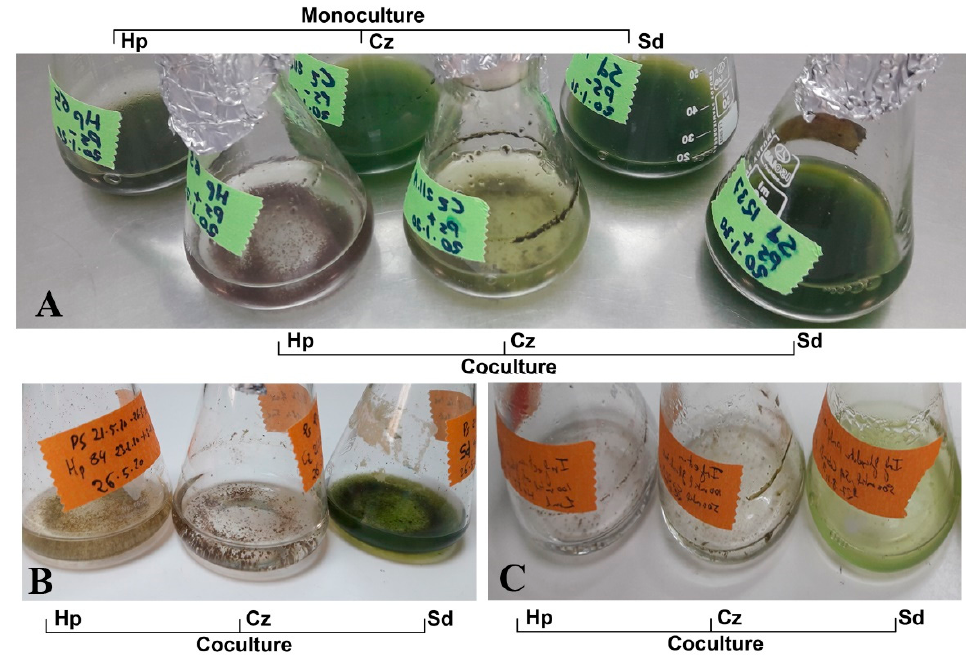
Figure 2. Virulence of different types of P. sedebokerense inoculum against H. pluvialis (Hp), C. zofingiensis (Cz) and S. dimorphus (Sd) algal cultures. ( A ) Algal monocultures inoculated with logarithmic P. sedebokerense cultures, 5 days after inoculation and negative controls (the same algal monocultures without inoculation of the parasite). ( B ) Algal monocultures 2 weeks after inoculation with Ps-Hp coculture (same volume of inoculum to each algal culture). ( C ) Algal monocultures 5 days after inoculation with isolated propagules from Ps-Hp coculture, containing both amoeboid swarmers and flagellated zoospores. (ratio infection Ps-Hp 1:3; Ps-Cz 1:30, P-Sd 1:10).